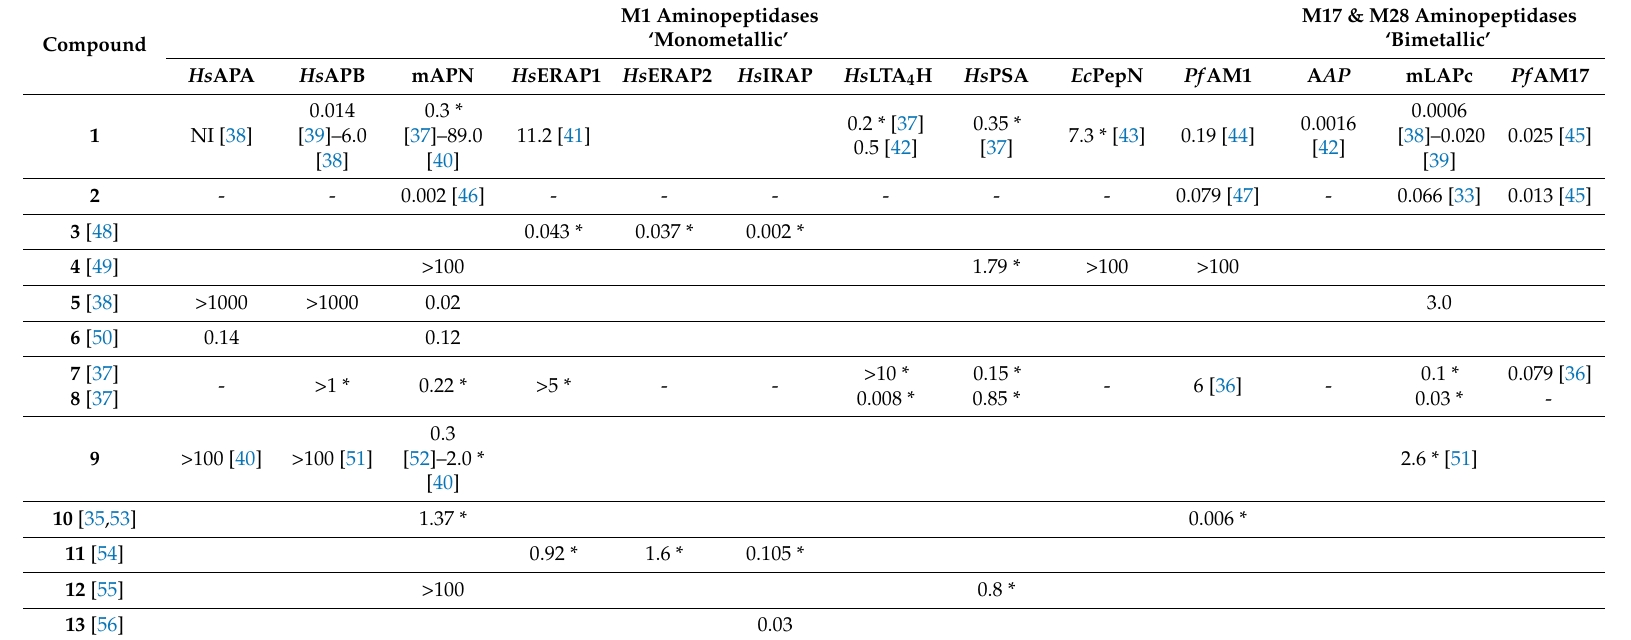
Table 3. K i or * IC 50 values in micromoles reported in literature for representative M1 AP’s